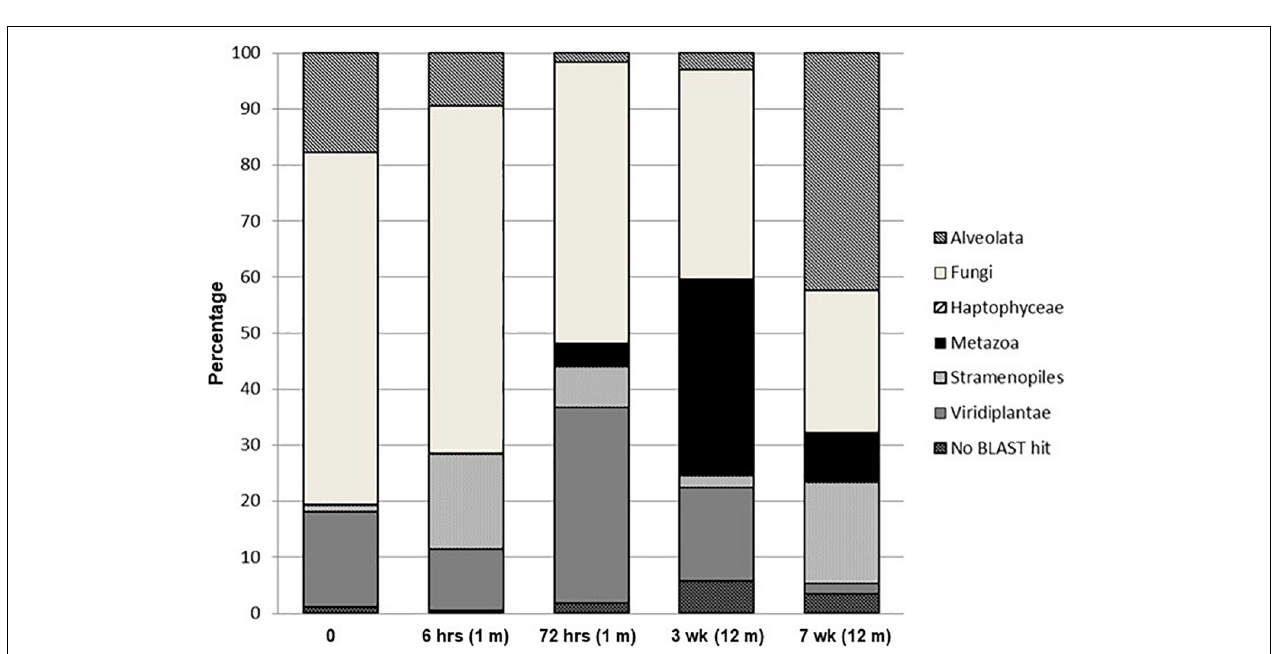
FIGURE 3 | Percentage distribution of bacterial phylogenetic groups from pyrosequenced 16S rRNA genes.